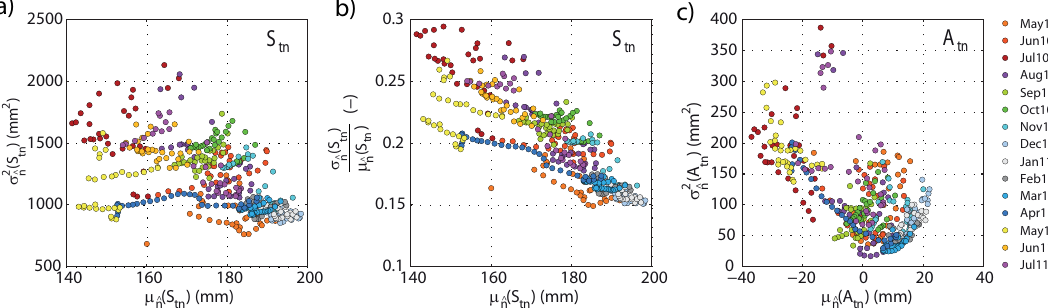
(S tn ) ) vs spatial variance ( σ 2 (S tn ) ) of daily absolute soil moisture, (b) the coefficient b n b n (S tn ) ) of daily absolute soil moisture, as well as (c) the spatial mean ( µ b n